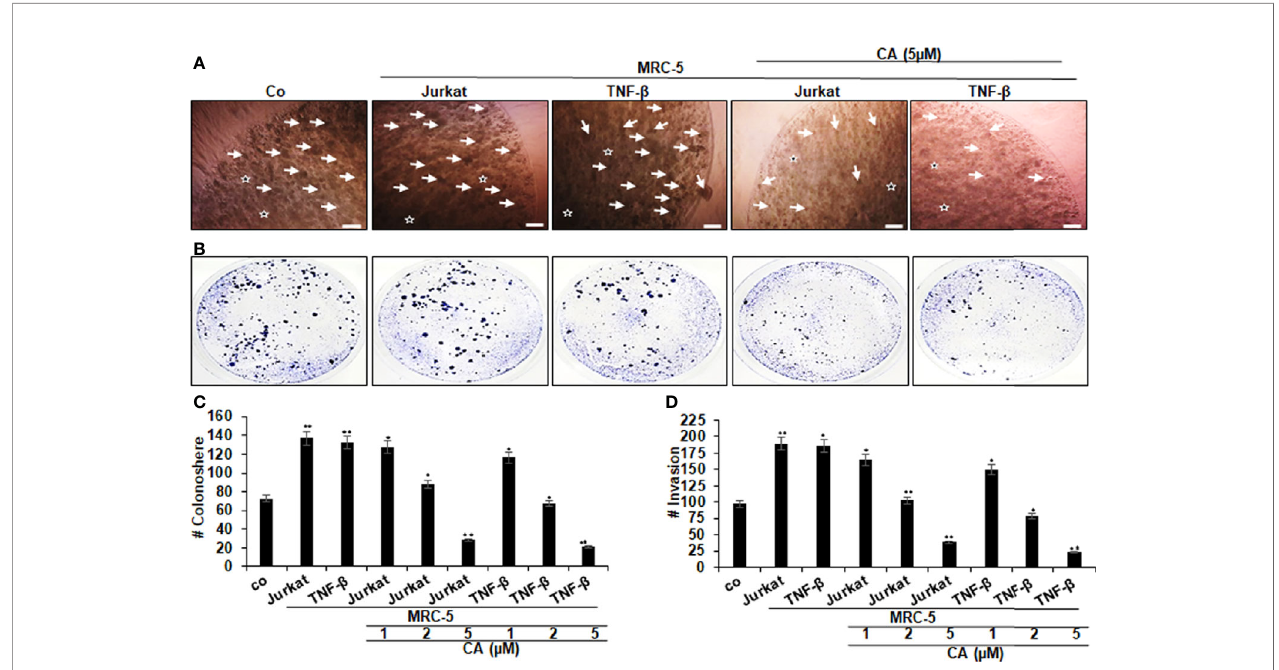
FIGURE 3 | Effects of Calebin A on multicellular proin fl ammatory TME-induced HCT116 cell colony formation and invasion in 3D-alginate culture. Serum-depleted cultures of HCT116 cells in 3D-alginate (*) cultures alone (co) or co-cultured with fi broblasts (MRC-5) and T-lymphocytes (Jurkat) or cocultured with fi broblasts and TNF- b (10 ng/ml) were either left untreated or treated with different concentrations of Calebin A (CA) as described in Materials and Methods . (A) Colonosphere formation and (B) invasion were examined by light microscopy after 10 days. All experiments were performed at least three times. The number of colonospheres (A, arrows) was quanti fi ed by counting 20 different microscopic fi elds (C) , and the number of attached colonies as invasion parameter stained with toluidine blue was quanti fi ed in each well (D) . * p < 0.05 and ** p < 0.01 indicate a signi fi cant difference compared with the control group. Magni fi cation A: 24×, bars = 0.2